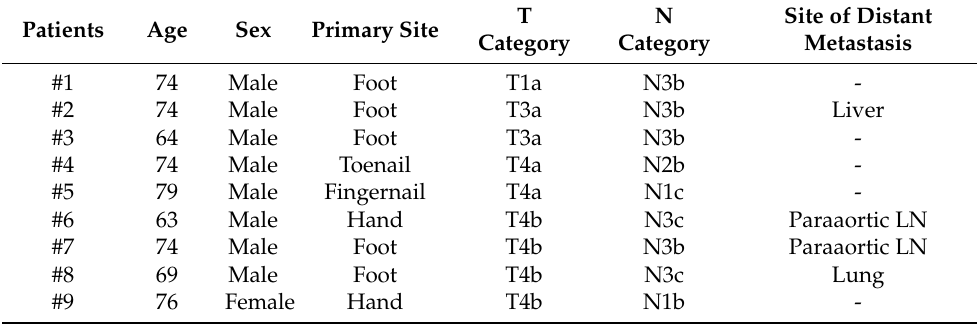
Table 4. Detection of metastasis in nine patients with clinical